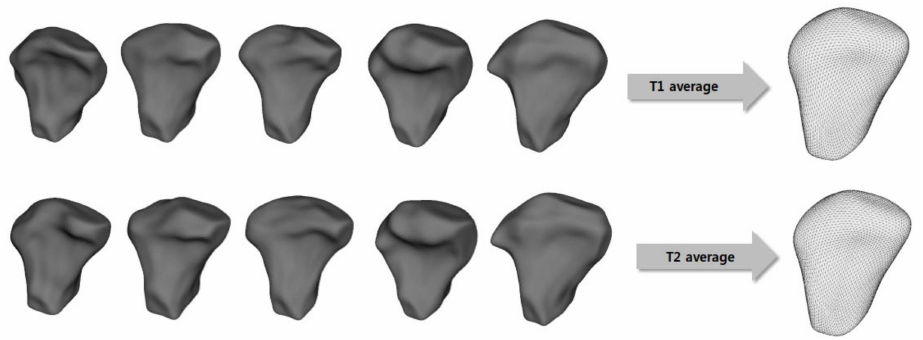
Figure 3. The creation process for the group average surface mesh model for pre-treatment (T1) and post-treatment (T2)